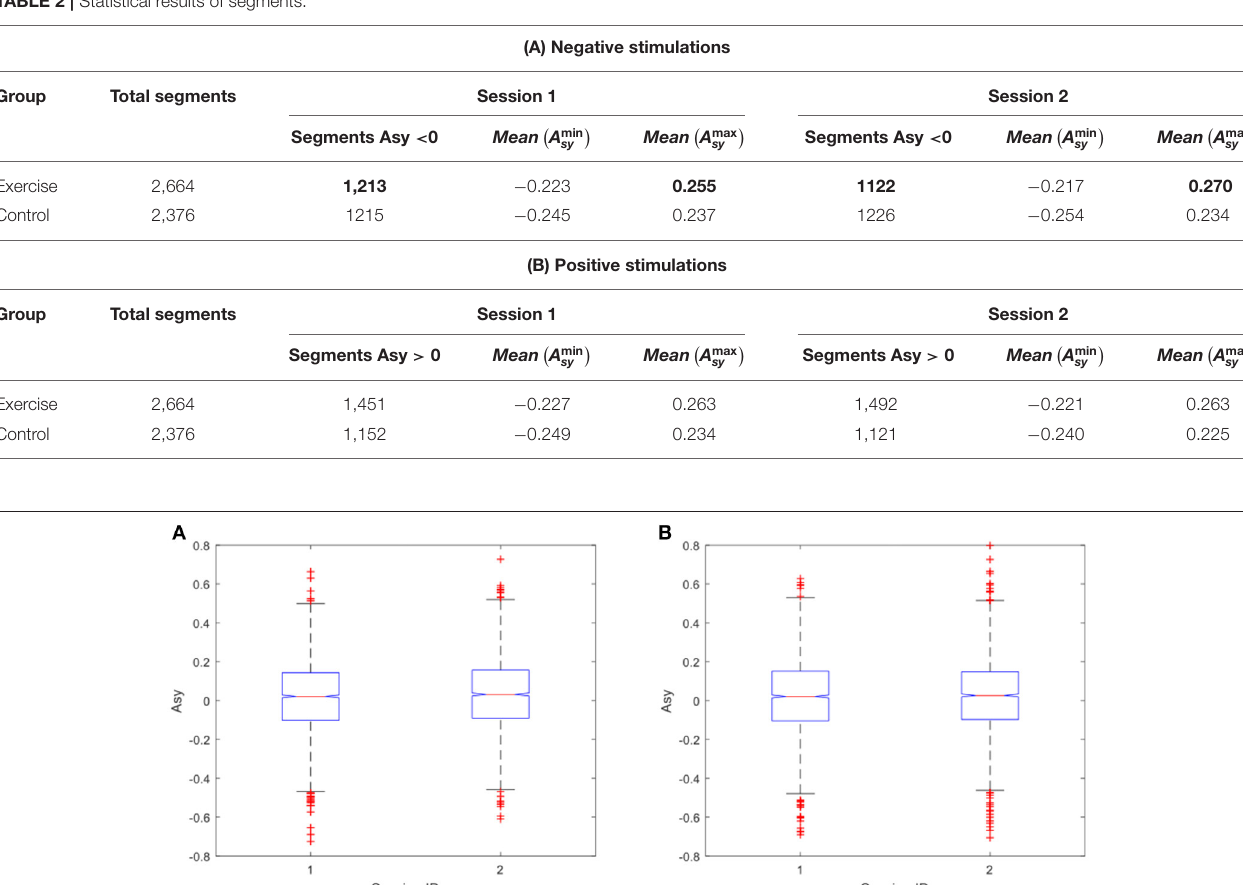
TABLE 2 | Statistical results of segments.